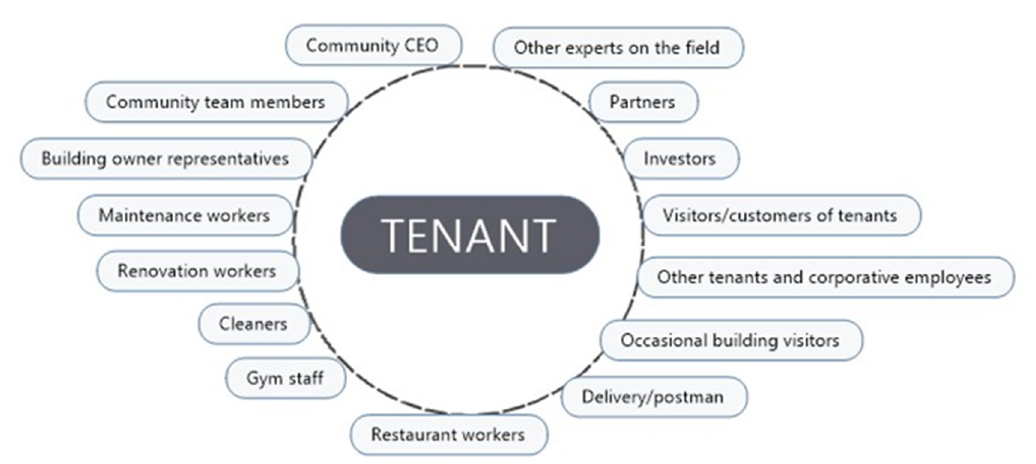
Figure 3. Key stakeholders at one of the studied buildings from the tenant’s point of view [62].